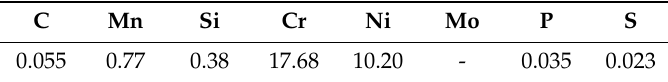
Table 1. Chemical composition of AISI 304 [%].